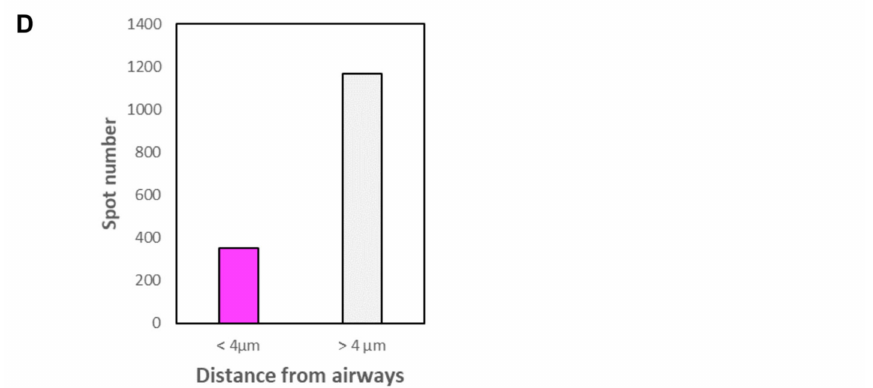
Figure 2. Distribution of RSV infected cells in whole mouse lung. ( A ) Maximal projections of light sheet acquisitions from whole mouse lungs sampled at 2 and 4 d.p.i. Lungs from mock-infected mouse were considered as control. In toto immunolabeling was processed with Streptavidin coupled to Alexa 488 to reveal airways (green) and anti-mCherry to reveal RSV infected cells (magenta). White dotted squares delineate the region presented in a magnified view in the bottom panel. ( B ) 3D surface rendering of airways (green) and RSV infected cells displayed as spots in a portion of the lung (59.9 mm 3 ) at 2 d.p.i. Spots are displayed in different colors according to their distance from airways; magenta when inferior to 4 µ m and or white when superior to 4 µ m. ( C ) Counting of RSV infected cells displayed as colored spots with the color code corresponding to their distance from airways. ( D ) Quantitation of RSV infected cells based on 3D image